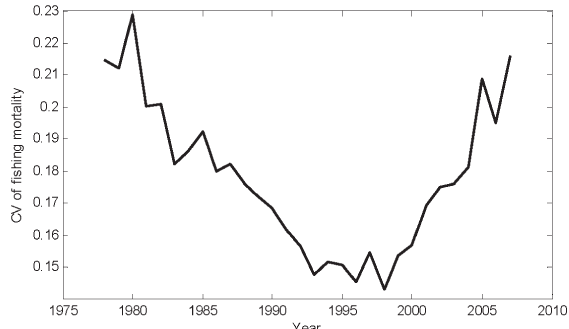
Fig . 10. – CVs of fishing mortality from 1978 to 2007 estimated from the Bayesian statistical catch-at-age